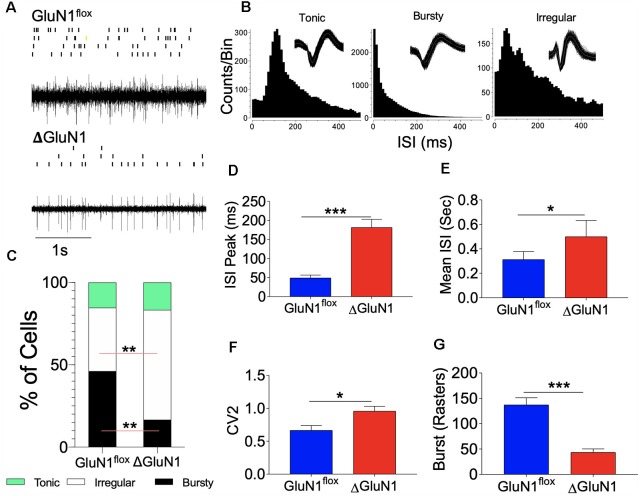
Interspike interval (ISI) characterization of CA1 spike train. (A) Single unit spike train and rasters recorded form the CA1 dendritic field. (B) Representative Interspike ISI histograms and waveform for tonic, bursty and irregular firing CA1 trains neuron units. (C) Composite bar graph depicting the percentage of CA1 neuron units based on ISI characterization of firing pattern. (D–F) Bar graphs illustrating ISI peak duration (ms), Mean ISI (ms), and CV2 of ISI for CA1 spike trains. (G) Bar graph illustrating the number of bursts recorded in the spike train per unit time (D–G; *p < 0.05, **p < 0.01, ***p < 0.001).